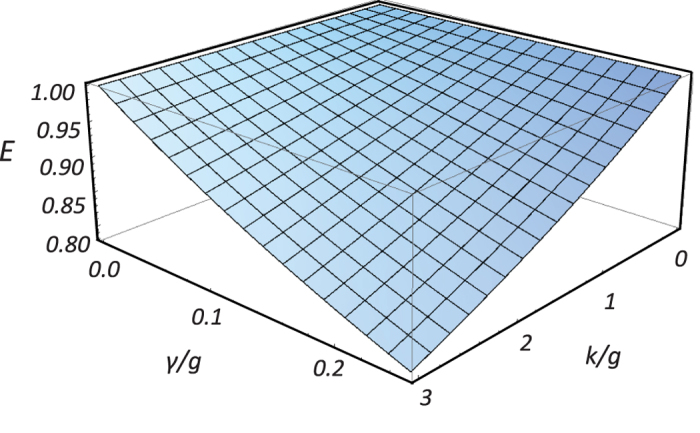
The efficiency (in amplitude) functions of γ/g and κ/g at gh = gv = g and ω = 0.